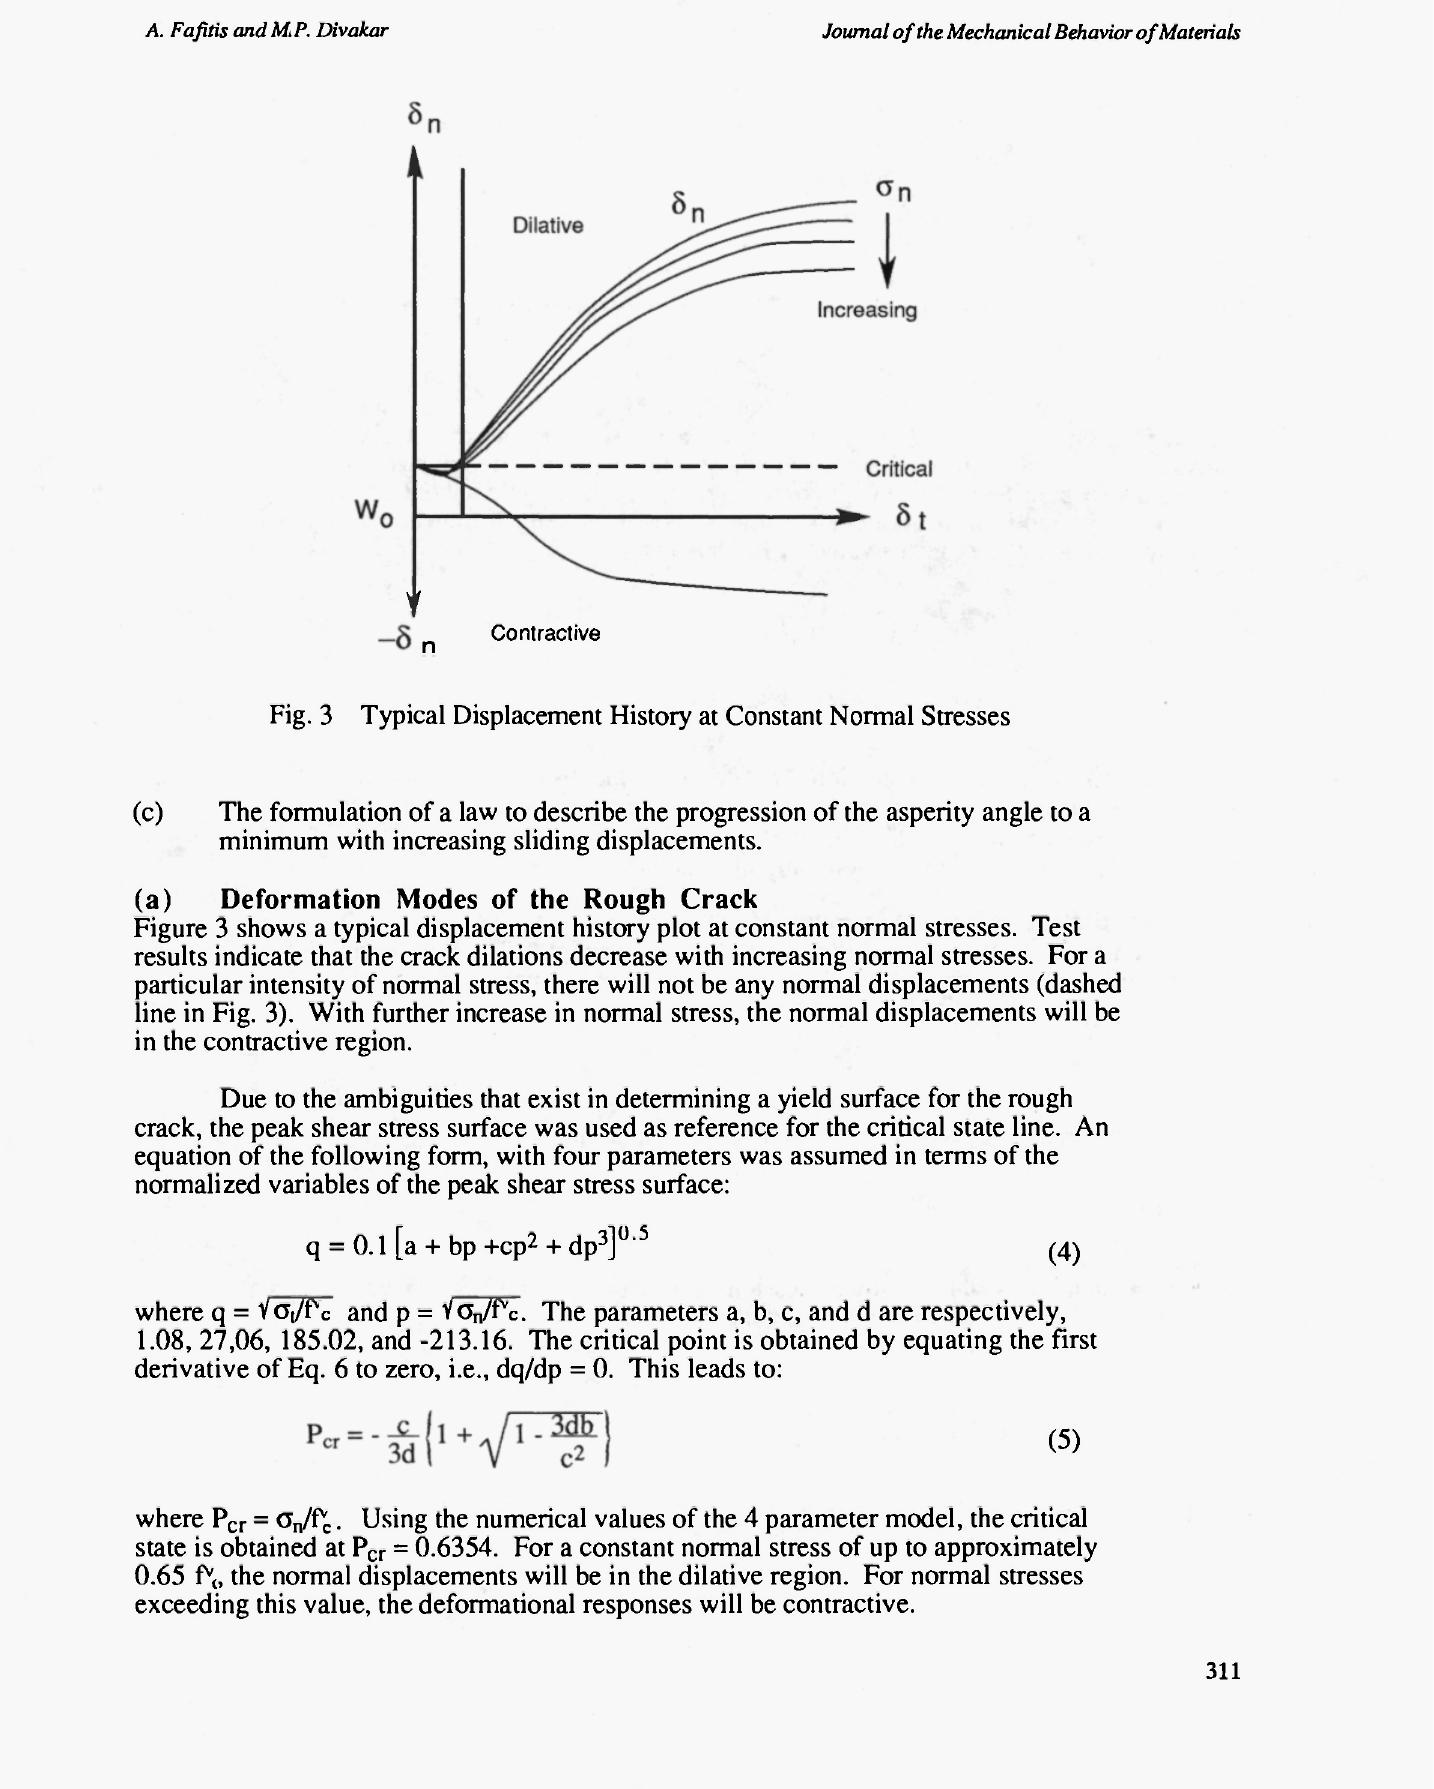
(c) The formulation of a law to describe the progression of the asperity angle to a minimum with increasing sliding